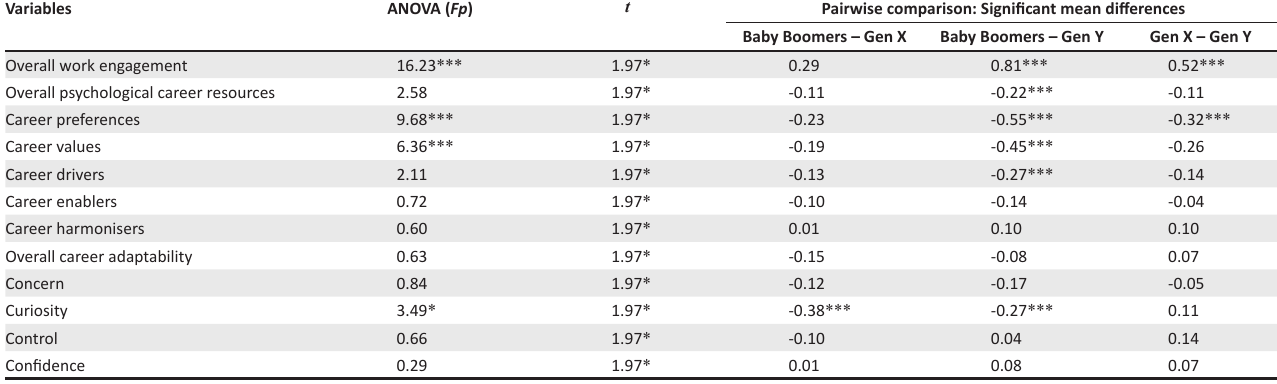
TABLE 3: Pairwise comparison of mean differences – ANOVA results: generational cohort (age).